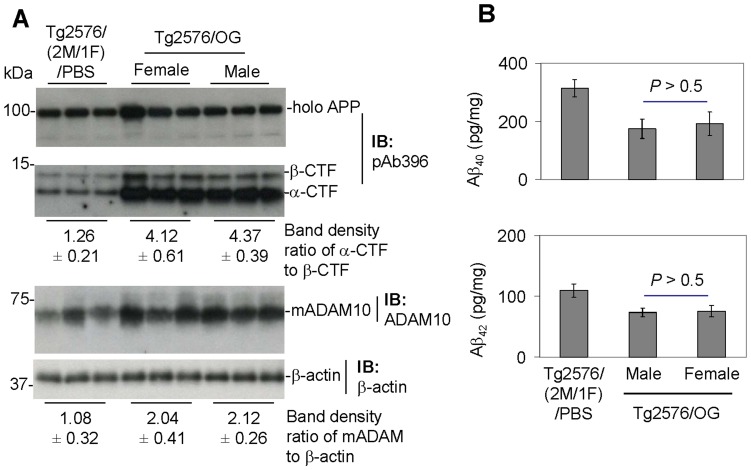
Female and male Tg2576 mice do not show a significant difference in terms ofα-secretase processing of APP and soluble cerebral Aβ levels upon OG treatment.A total of 13 Tg2576 mice were used in this study over a period of one week. Five female and five male Tg2576 mice received OG, and the remaining three mice (2 male/1 female) received PBS. Beginning at 6 months of age, these Tg2576 mice were i.c.v. injected with OG (10 µg in 5 µl PBS) or PBS (5 µl) daily through the implanted cannulae for one week. Mice were sacrificed 24 hours after the last injection for analysis of CTFs of APP, ADAM10 activation and Aβs in brain homogenates using IB analyses and ELISA. IB analysis show (A, top) holo APP and two bands corresponding to β-CTF and α-CTF by an APP-carboxyl-terminal antibody (pAb396) and (A, bottom) mADAM10 by an anti-carboxyl-terminal ADAM10 antibody (ADAM10). As shown below each IB, densitometry analysis shows the band density ratios (mean ± SD) of α-CTF to β-CTF and mADAM10 to β-actin. (B) Detergent-soluble Aβs were analyzed by ELISA. Data are represented as mean ± SD of Aβ (pg/mg protein). For (B), a t-test revealed no significant difference between female and male OG-treated Tg2576 mice for total soluble Aβ (P>0.05). Most notably, both OG-treated female and male Tg2576 mice show much higher levels of APP processing into α-CTF as well as mADAM10 compared with PBS-injected mice.